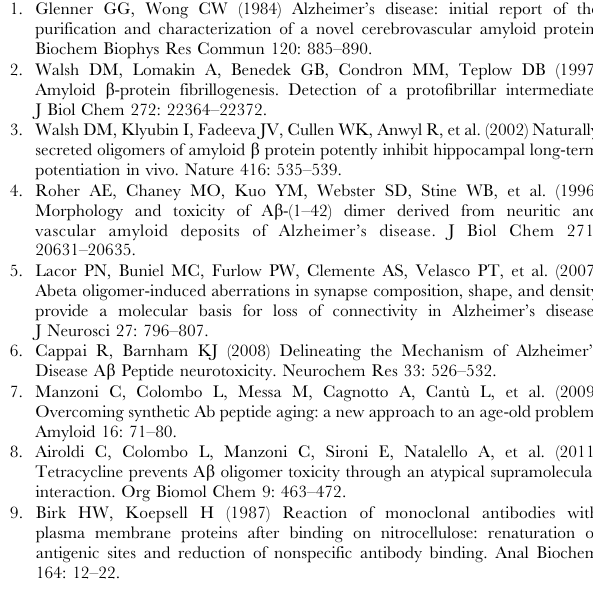
Figure S2 An A b 1–42 batch of lyophilized peptide was